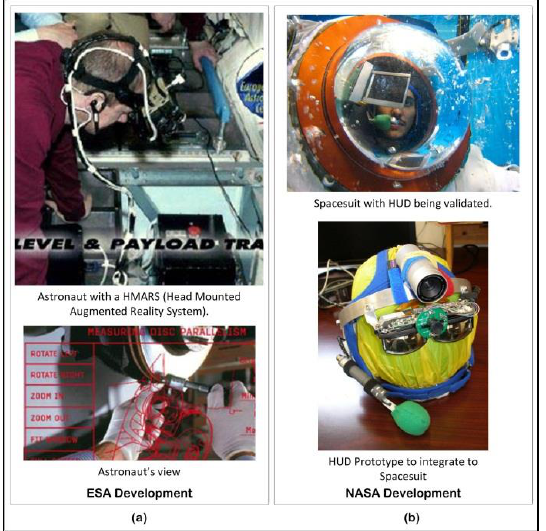
Fig. 7. (a) ESA Augmented Reality system to ISS crew [11]. (b) NASA upgrades to HUD for spacesuits [9].